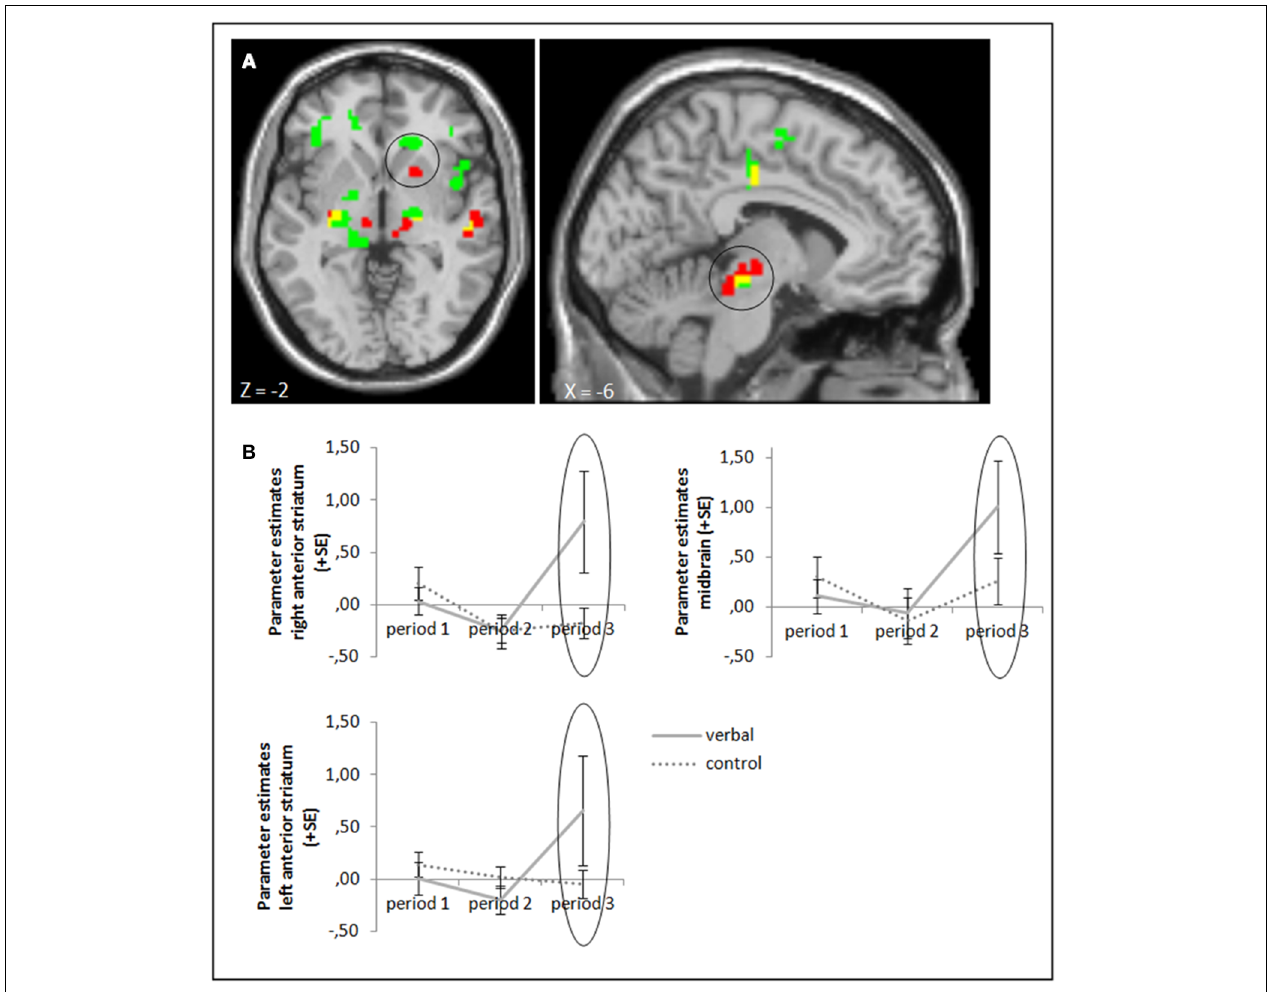
FIGURE 4 | (A) Activation for success—failure feedback was significantly higher in the right anterior striatum (left panel) and midbrain (right panel) in the verbal reward group compared to the control group in period 3 (whole brain uncorrected, p < 0 . 001, only clusters with a minimum of 10 activated